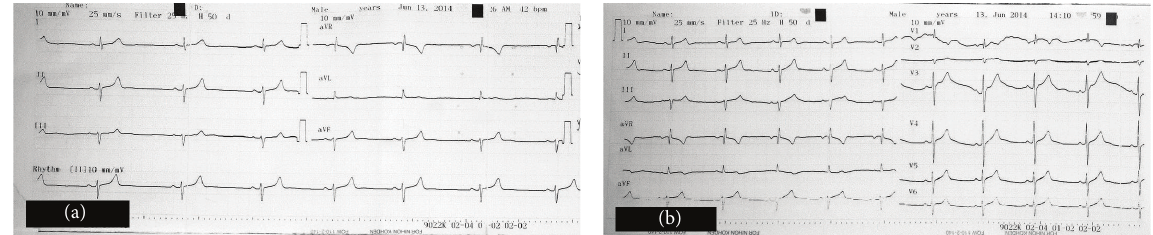
Figure 2: (a) Initial electrocardiography of Case 2 with sinus bradycardia. (b) Electrocardiography of Case 2, 45 minutes after initiation of intravenous lipid emulsion infusion.